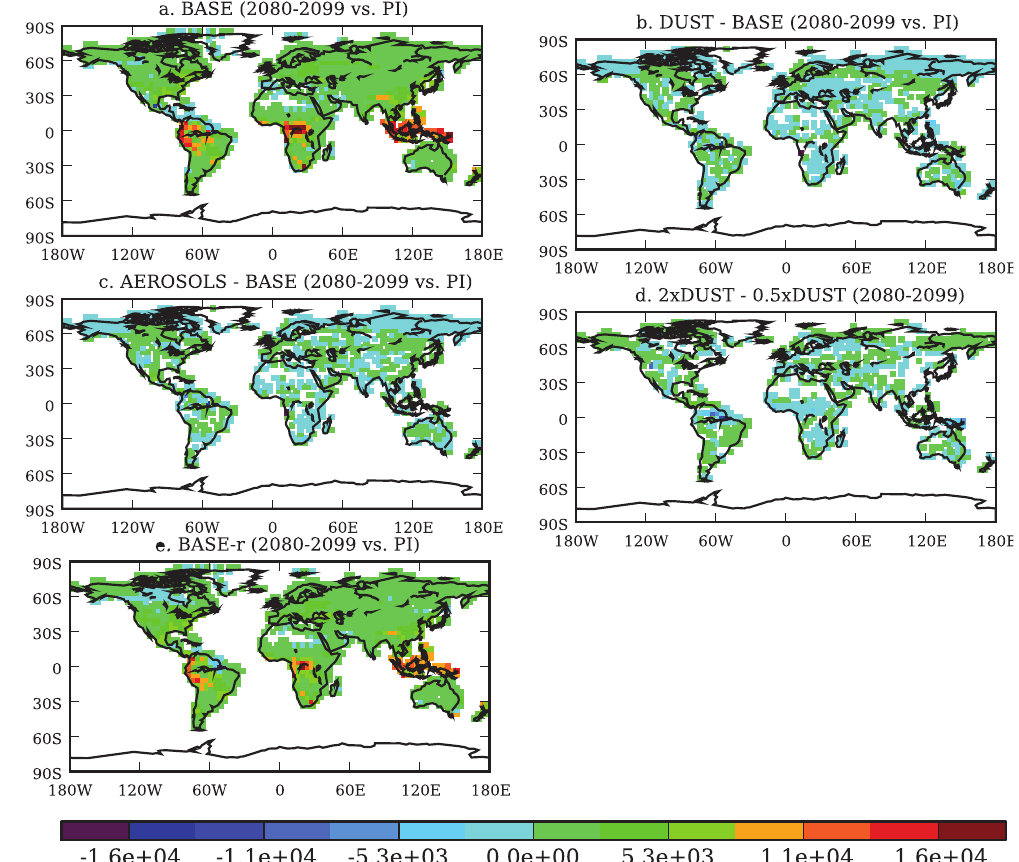
Fig. 11. Total column carbon on land (gCm − 2 ) for 2080–2099 relative to the preindustrial control for each case: (a) mean change for 3 ensemble base case members, (b) differences from base case differences for interactive dust (DUST), (c) differences from base case for interactive aerosols (AEROSOL), (d) difference between 2xDUST and 0.5DUST cases, and (e) mean change for 3 ensemble BASE-r (CO 2 does not impact climate) case members. Only changes significant at the 95% level are shown in color. Note that panels (b) , (c) , (e) and (f) show differences from the 3 BASE case differences from preindustrial (for example: (DUST2080-2099 minus DUST-control) minus (BASE2080-2099 minus